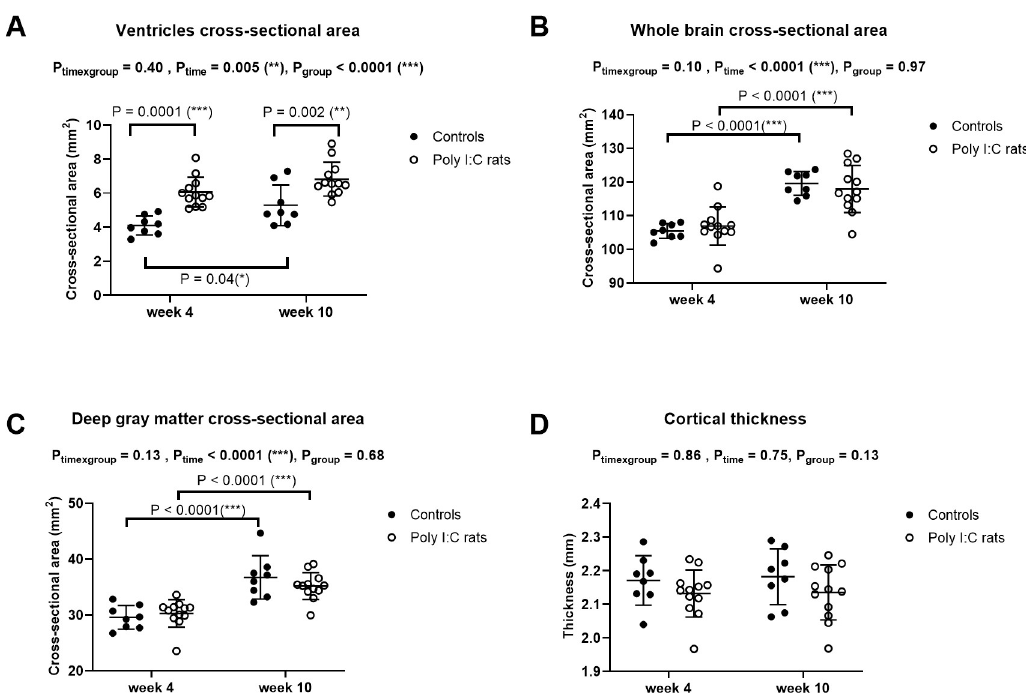
Fig 3. Anatomical abnormalities. Cross-sectional areas of the ventricles (A), whole-brain (B), deep gray matter (C), and cortical thickness (D) measured in controls (n = 8, •) and poly (I:C) rats (n = 12, � ) at week 4 and week 10 after birth (mean ± standard deviation). Data were analyzed with a repeated two-way ANOVA with Sidak’s multiple